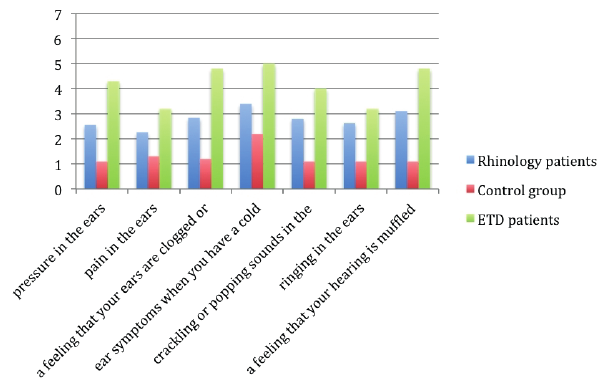
Figure 3. Mean ETDQ-7 scores by